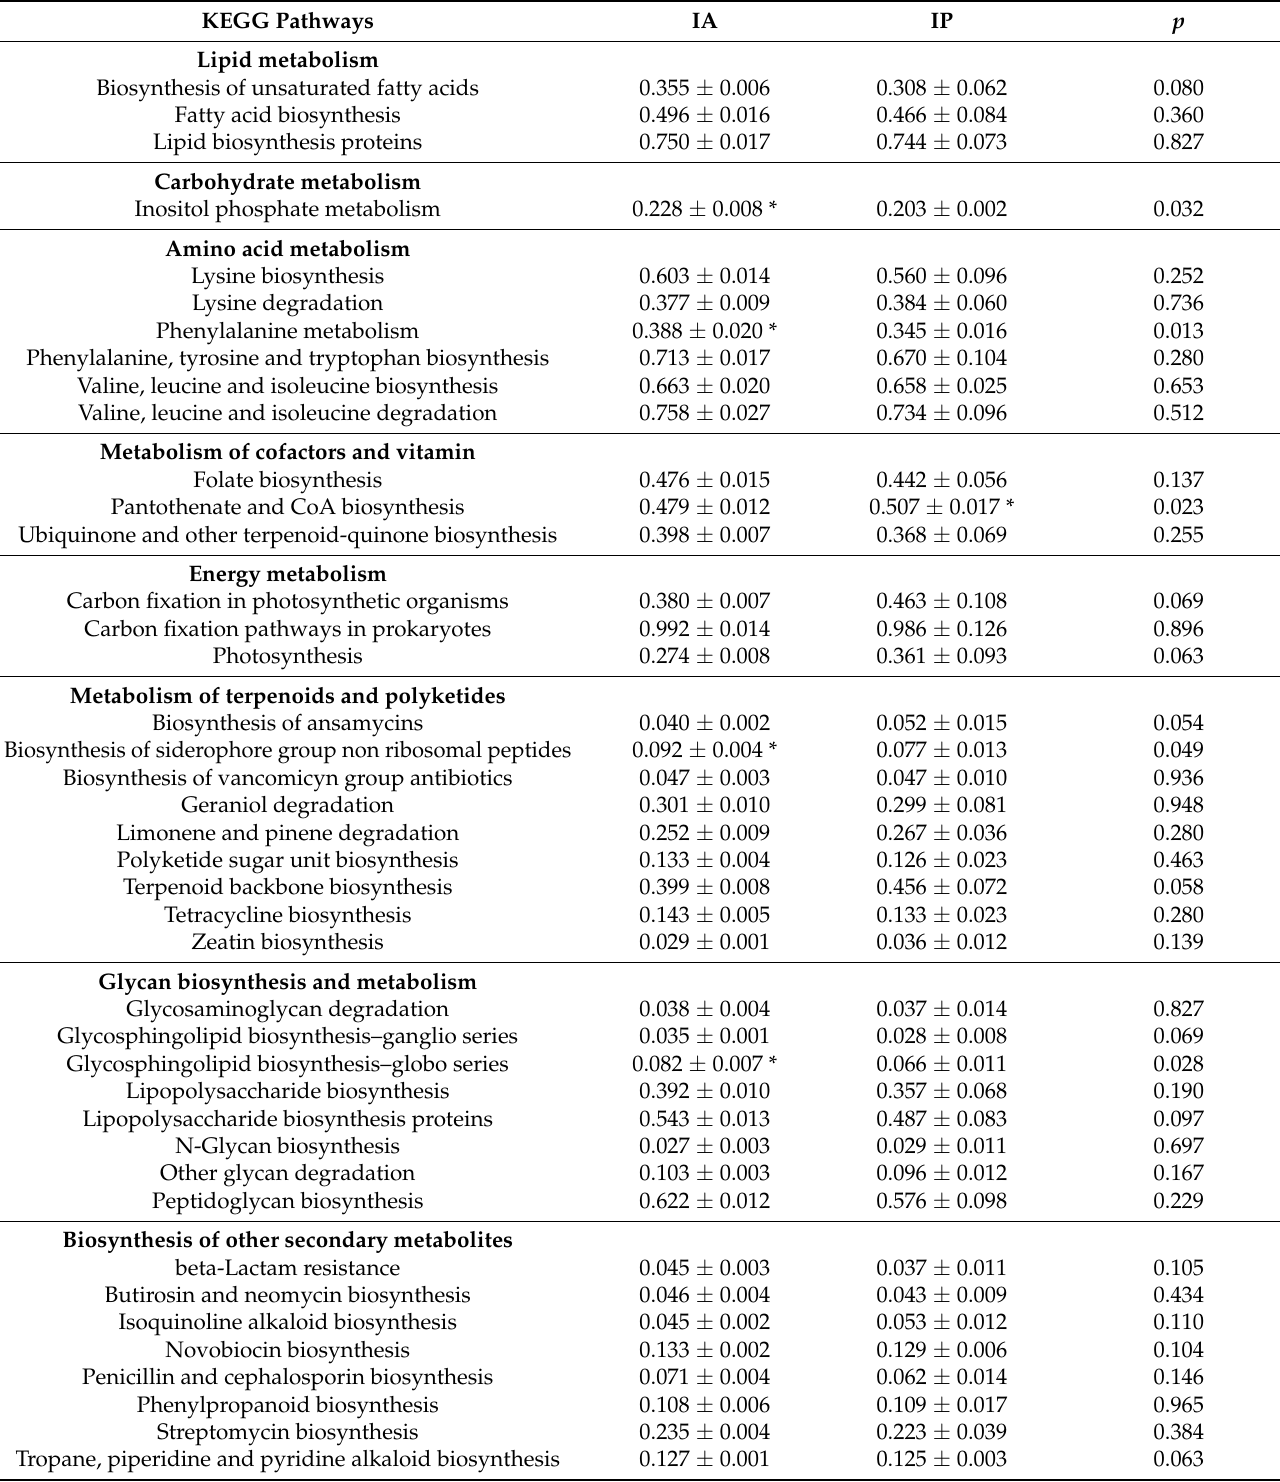
Table 2. Relative abundance (%) of the functional predictions on the microbial composition of anterior (IA) and posterior (IP) intestinal sections of wild C. labrosus at KEGG level 3. In the table, functions with a relative abundance ≤ 0.020% have been